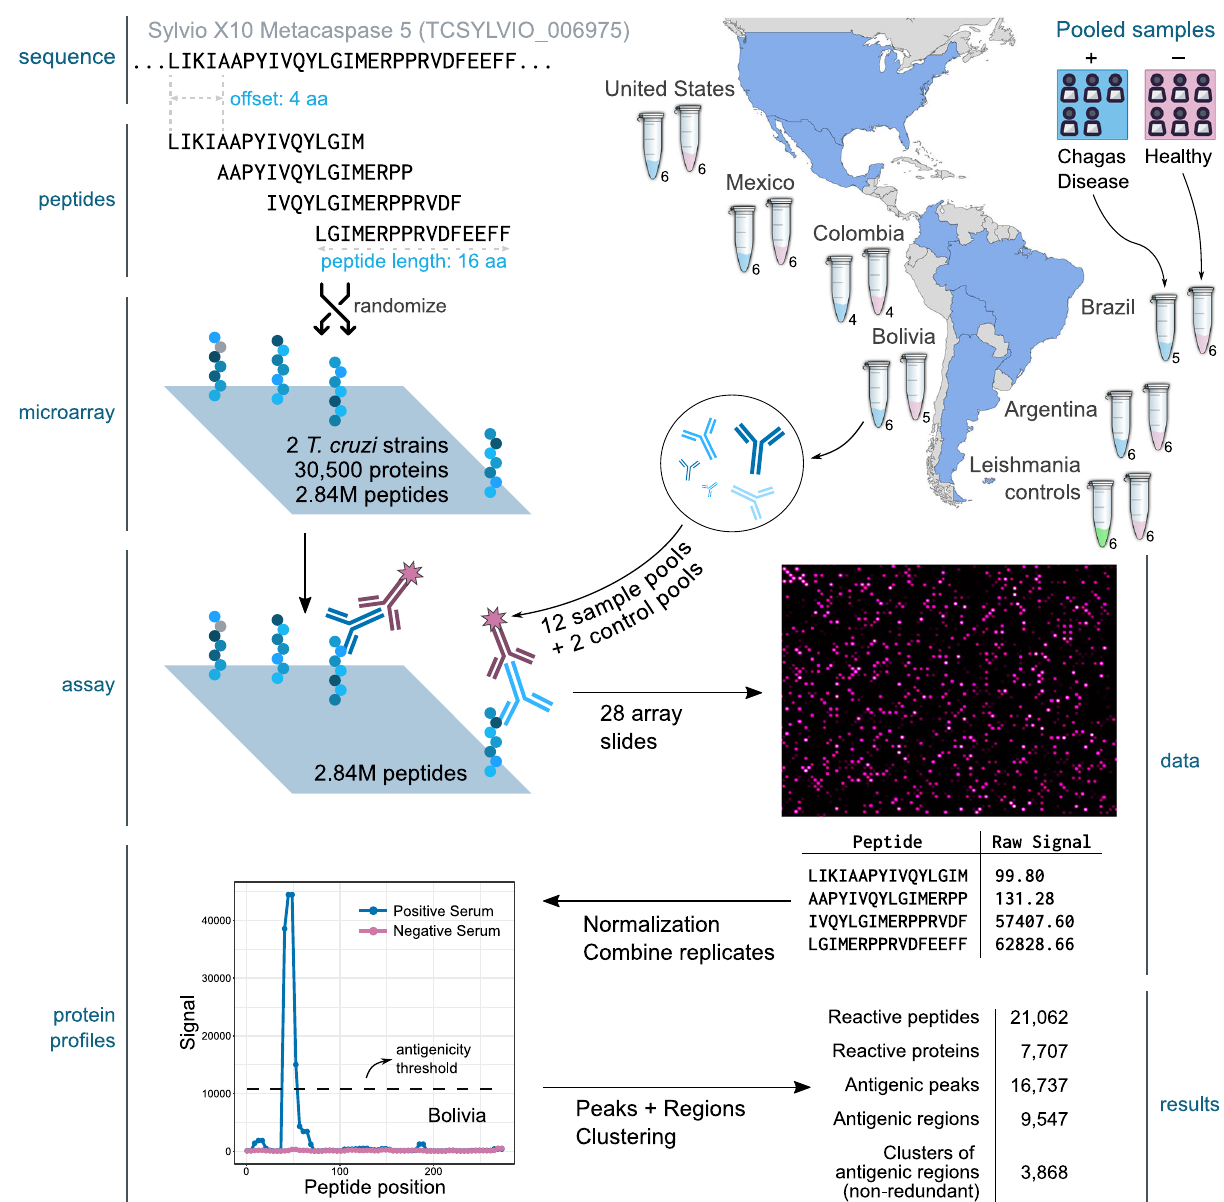
Fig. 1 | Summary of the discovery screening. The fi gure shows a schematic representation of the steps followed to analyse two T. cruzi proteomes (CL-Brener and Sylvio X10) using pooled serum samples across the Americas (one pool from Chagas-infected individuals and one from healthy subjects from Argentina, Brazil, Bolivia, Colombia, Mexico, and the United States). The numbers below each tube represent the number of individual sera in each pool. An additional pooled serum sample of Leishmania-infected individuals and their healthy counterparts were